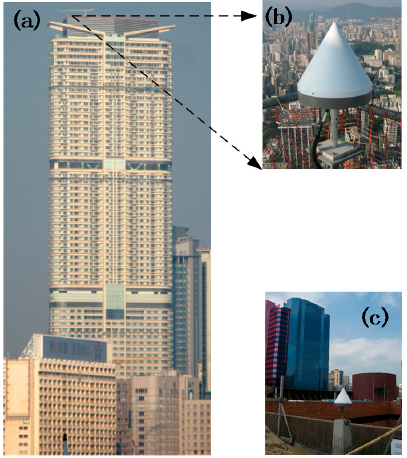
Figure 7. GPS monitoring system: ( a ) a monitored tall building; ( b ) GPS monitoring station; and ( c ) GPS reference station.